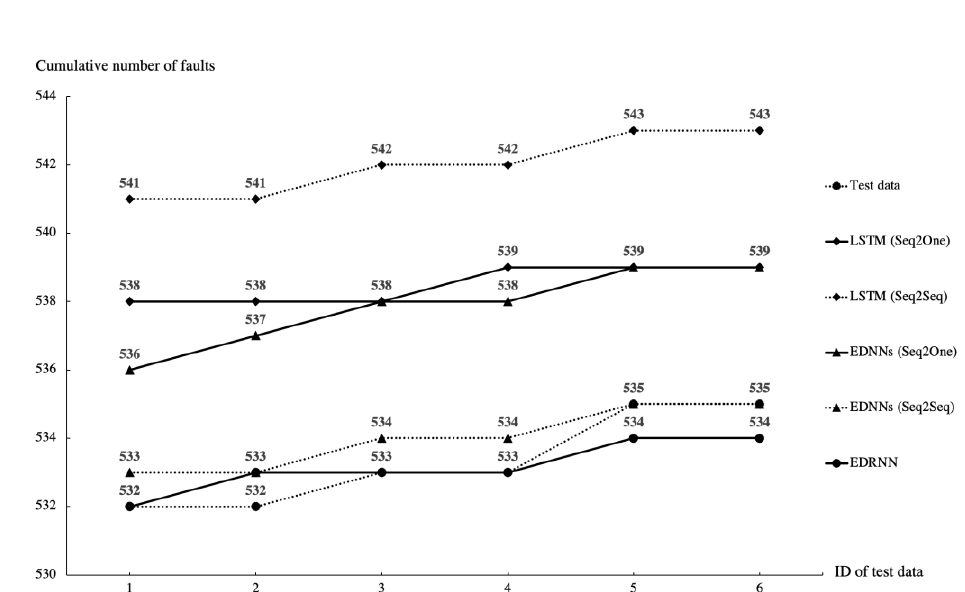
Figure 7. Predicted results of the proposed model (EDRNN) compared with neural network-based models.